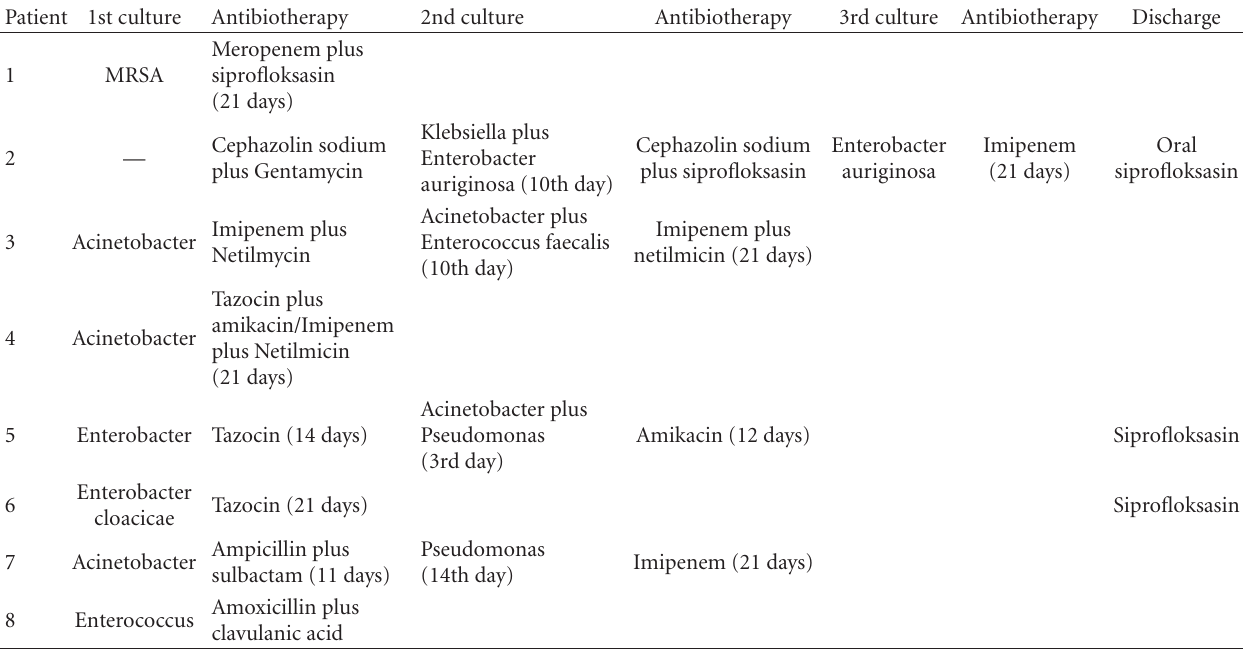
Table 4: Incubated cultures and treatment procedures of the infected